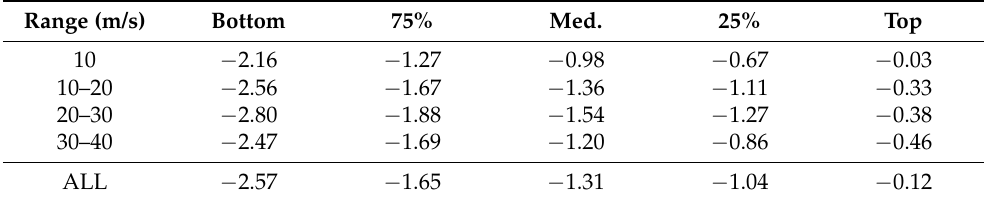
Table A3. The distribution of the required acceleration at the braking start point.